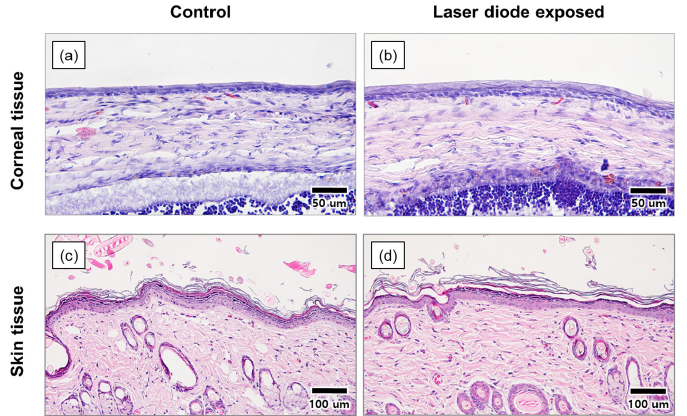
Figure 8. ( a , b ) Corneal, ( c , d ) skin tissue images of the Sprague Dawley rat. ( b , d ) tissue images are obtained after 30 min of irradiation of NIR LDs in the rat to the eyes and back skin.